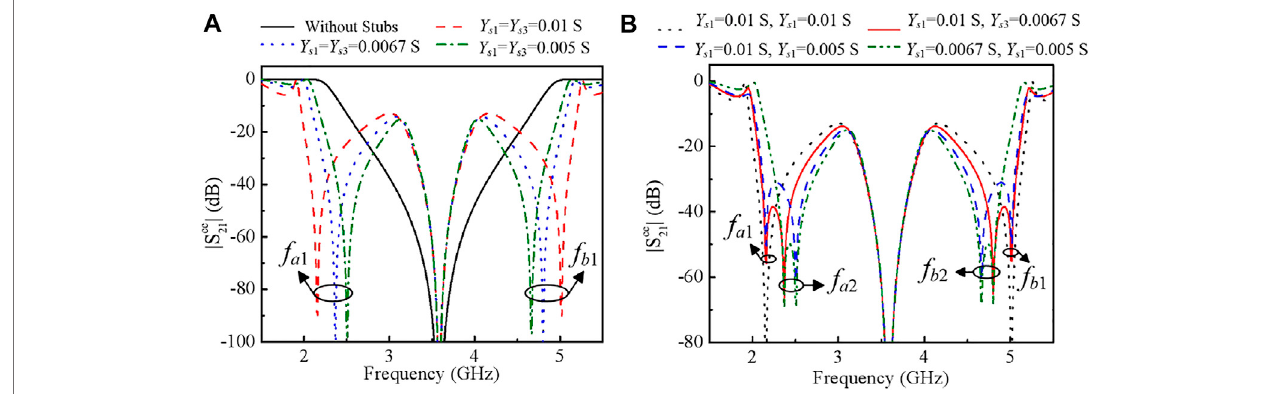
FIGURE 8 | Simulated results of CM bisection with loading two stubs on the fi rst and third resonator (A) Two identical stubs (B) Two different stubs.